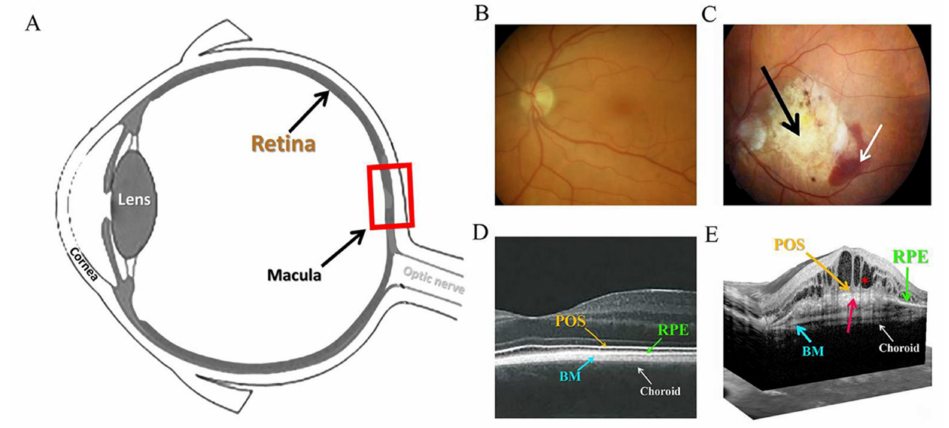
Figure 1. ( A ) Structure of the human eye, showing the retina and macula. ( B ) Fundus photograph of a healthy eye. ( C ) Fundus photograph of a fibrotic (black arrow) and treatment-tolerant wet age-related macular degeneration (AMD) eye. White arrow indicates the haemorrhage associated with active choroidal neovascularization. ( D ) Optical coherent tomography (OCT) image of healthy retina with the arrows pointing to the tissue segments. ( E ) Three-dimensional OCT image of fibrotic AMD retina. Fibrotic region is marked by a red arrow and apparent intraretinal oedema by a red asterisk. Abbreviations are included in the list of